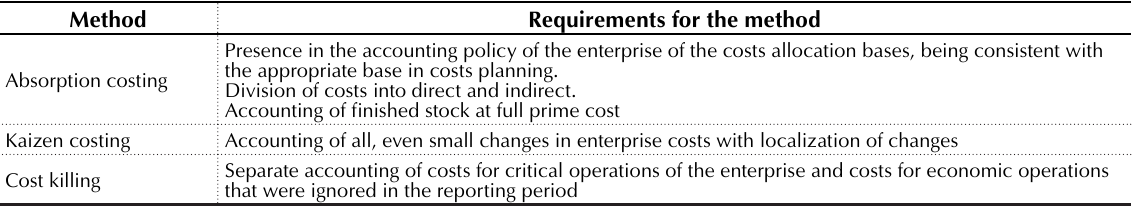
Table 4. Requirements for the costs accounting while using absorption costing, kaizen costing, and cost killing in operational enterprise costs management